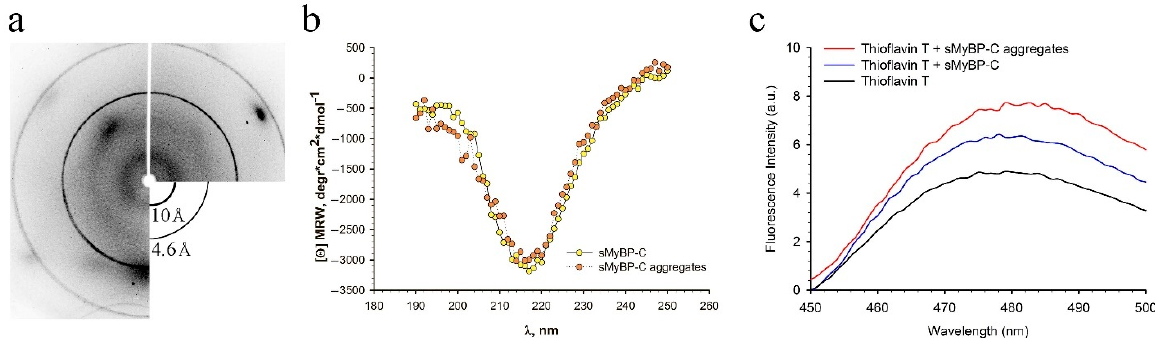
Figure 6. Corroboration of the amyloid properties of sMyBP-C aggregates by different methods. ( a ) X-ray diffraction of sMyBP-C aggregates after 24-h formation. Reflections were detected for sMyBP-C aggregates at 2.2, 3.1, 4.6, and 10 Å. The ~10 and ~4.6 Å diffuse reflections can be ascribed to a cross- β structure (Supplementary Figure S4). The 2.2 and 3.1 Å reflections were not identified; ( b ) CD spectrum of sMyBP-C. The α -helix content of non-aggregated sMyBP-C (0.3 M KCl, 4.8 mM K 2 HPO 4 , 5.2 mM KH 2 PO 4 , 0.1 mM DTT, 0.1 mM NaN 3 , pH 7.0) was 4.5%; the β -structure was 30.7%. The helix content of aggregated sMyBP-C (0.15 M glycine–KOH, pH 7.0) was 4.9%; the β -structure, 29.7%; ( c ) Thioflavin T fluorescence in the presence of sMyBP-C aggregates (24-h formation). Black line, thioflavin T fluorescence; blue line, ThT fluorescence in the presence of non-aggregated sMyBP-C; red line, ThT fluorescence in the presence of sMyBP-C aggregates.